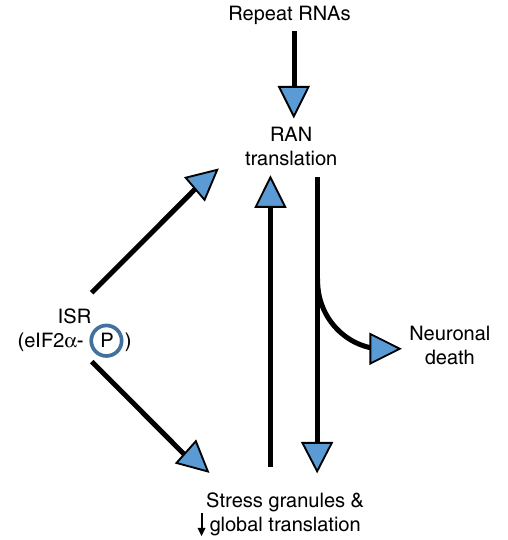
Fig. 7 Working model for how a feed-forward loop activates RAN translation and cellular stress pathways. Repeat expansions trigger RAN translation. RAN proteins or the repeat RNAs themselves then elicit stress granules and suppress global protein synthesis in a phosphorylated-eIF2 α - dependent manner. Activation of the integrated stress response (ISR)